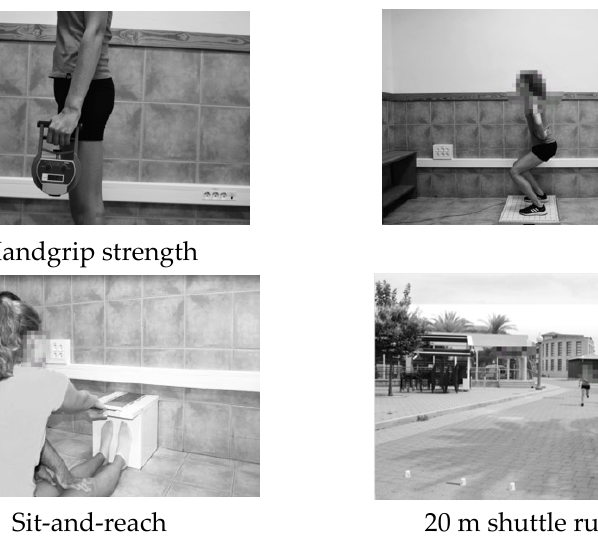
Figure 2. Physical performance tests.